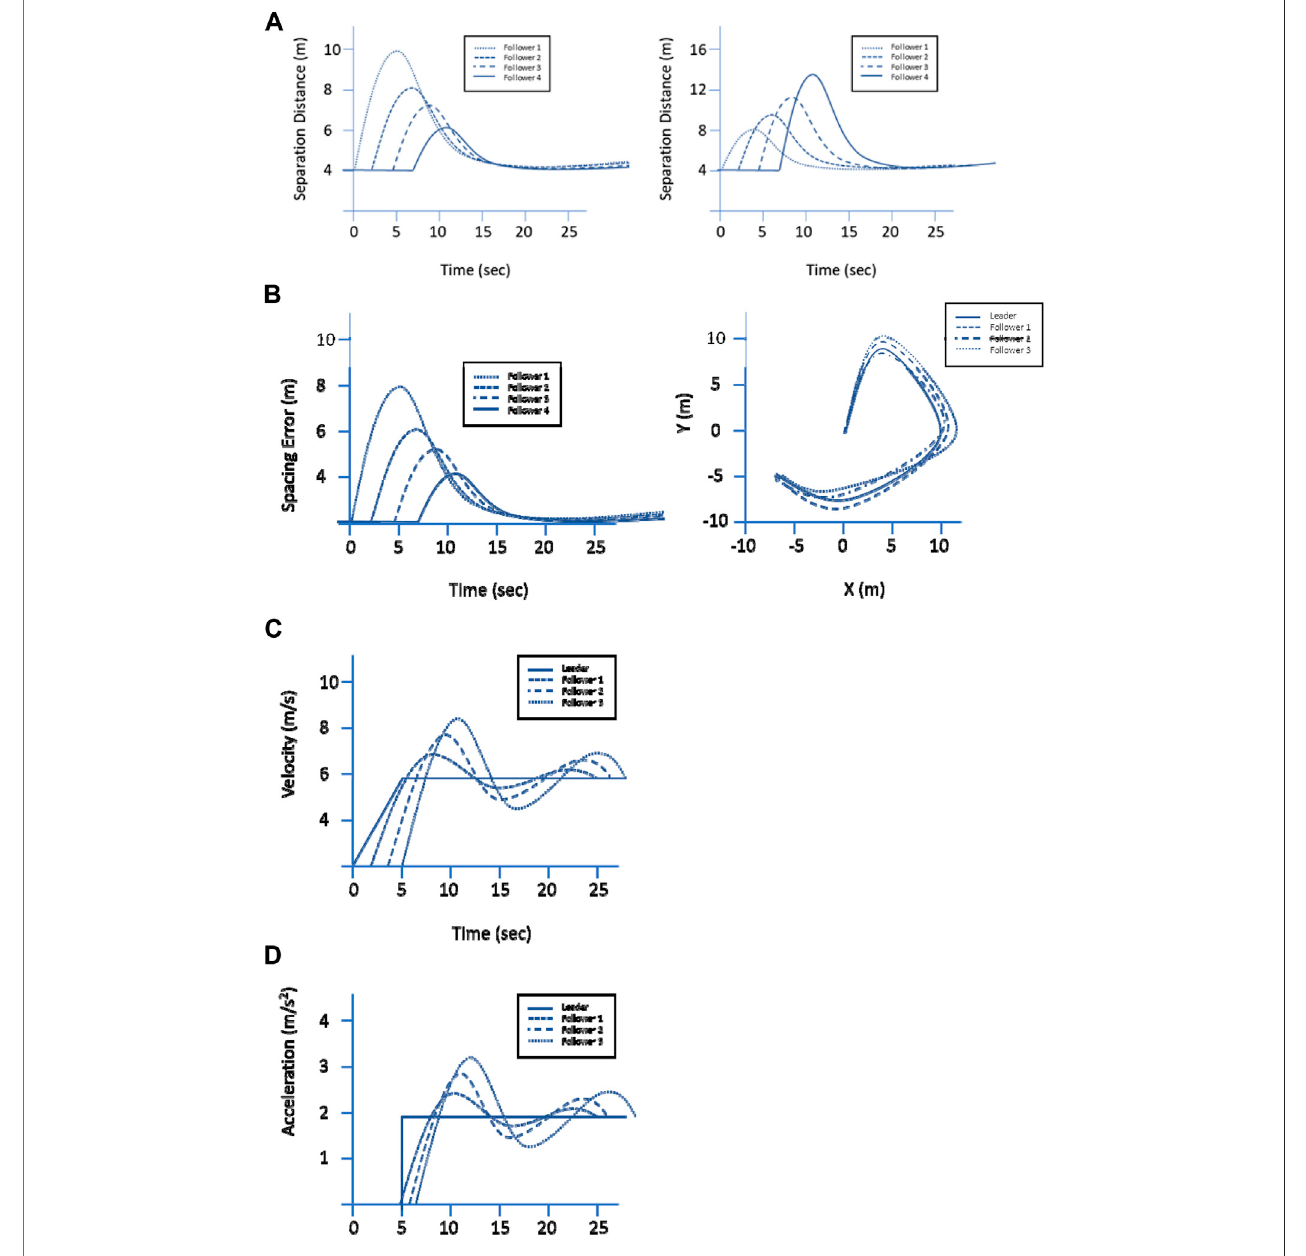
FIGURE 3 | Prevalent metrics for Convoy Vehicle Performance for (A) separation distance, (B) spacing error, (C) vehicle velocity, and (D) vehicle acceleration.